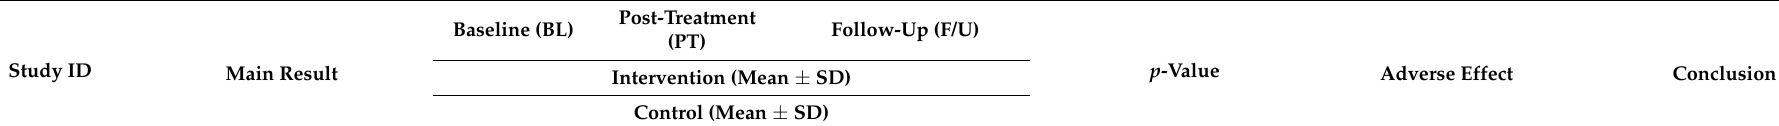
Table 3. Summary of the results and adverse effects of the included